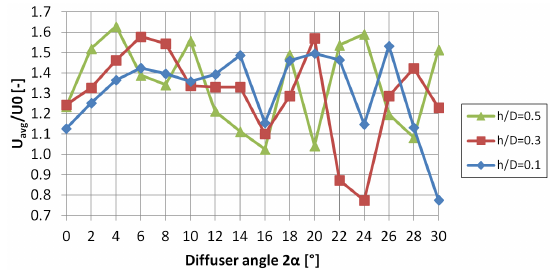
Figure 10: Comparison of averaged value of dimensionless velocity at the rotor inlet for all examined